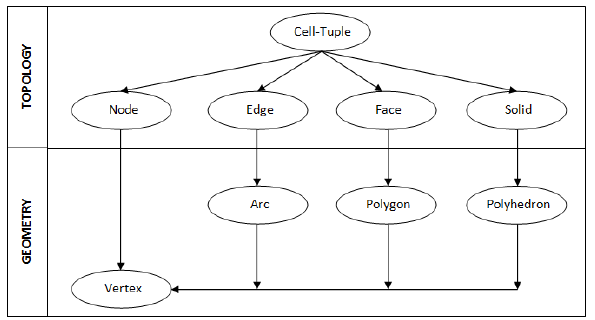
Figure 8. Cell-Tuple data structure's model in database.